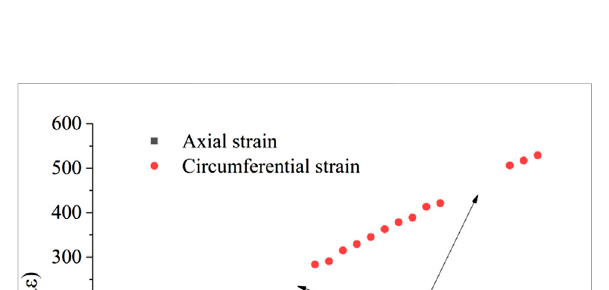
FIGURE 14 The 5 m hole depth stress variation in measurement hole No.